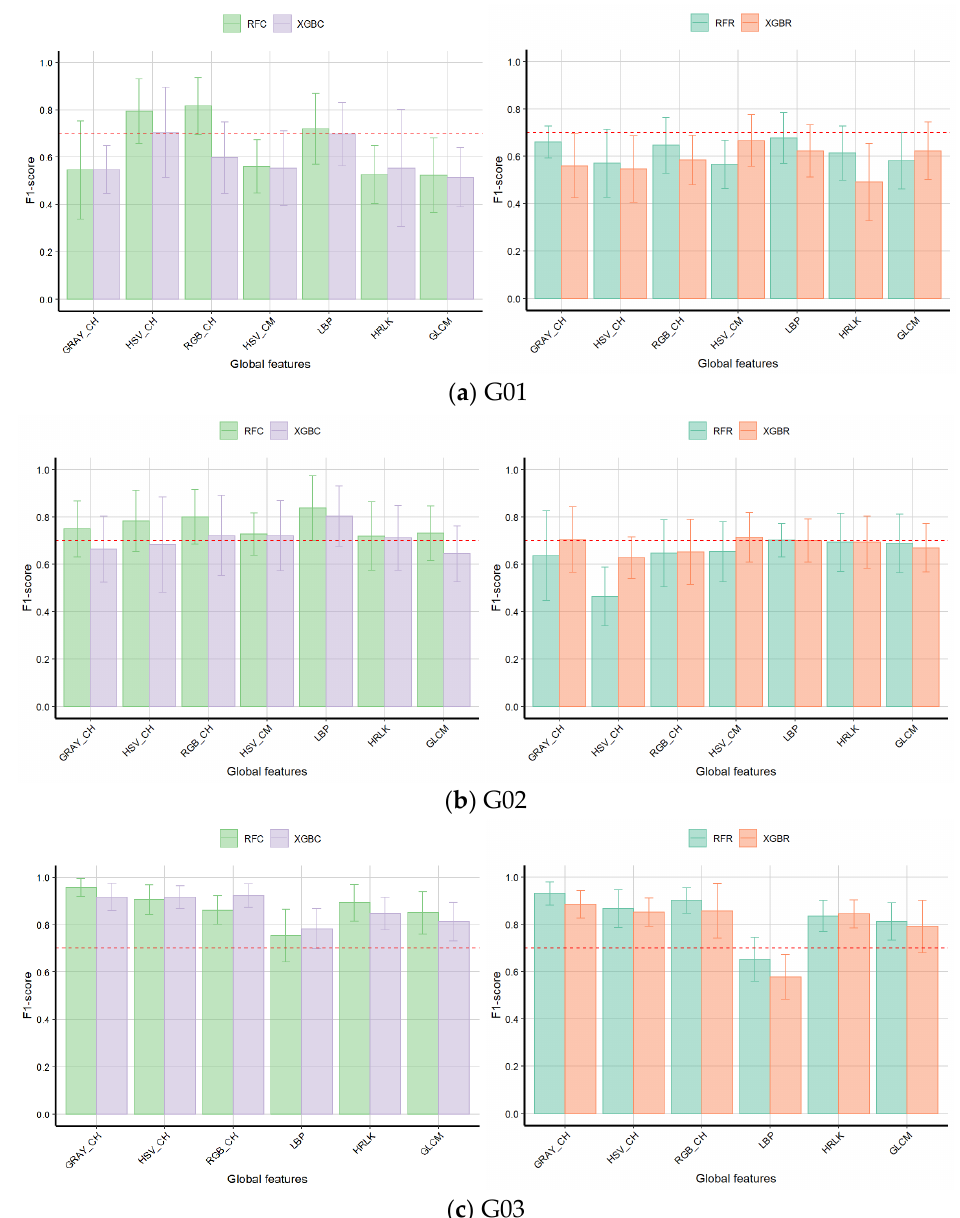
Figure 9. Performance of global descriptors under the datasets G01 ( a ), G02 ( b ), and G03 ( c ) with cropped images (940 × 940).